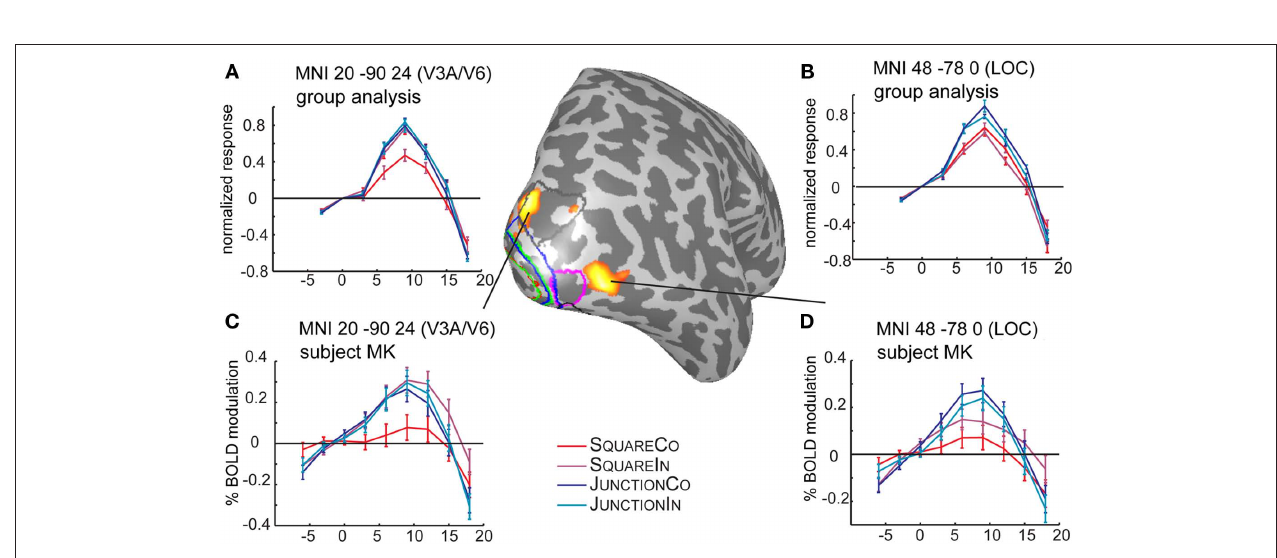
surface are the retinotopic regions in subject MK, V1 (red), V2 (green), V3 (blue), V3A/B (gray), OLF/LO1 (magenta). The MNI patch 20 − 90 24 partially overlaps with the V3A/B roi just next to the periphery of dorsal V3. The second patch (MNI 48 − 78 0), is located just anterior to the ROI OLF/LO1, depicted